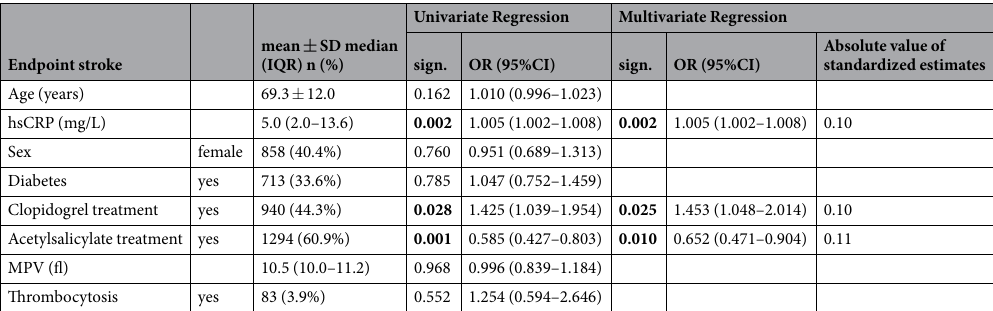
Table 4. Significant predictors for stroke. Abbreviations: MPV, mean platelet volume; sign., significance; hsCRP, high sensitive c-reactive